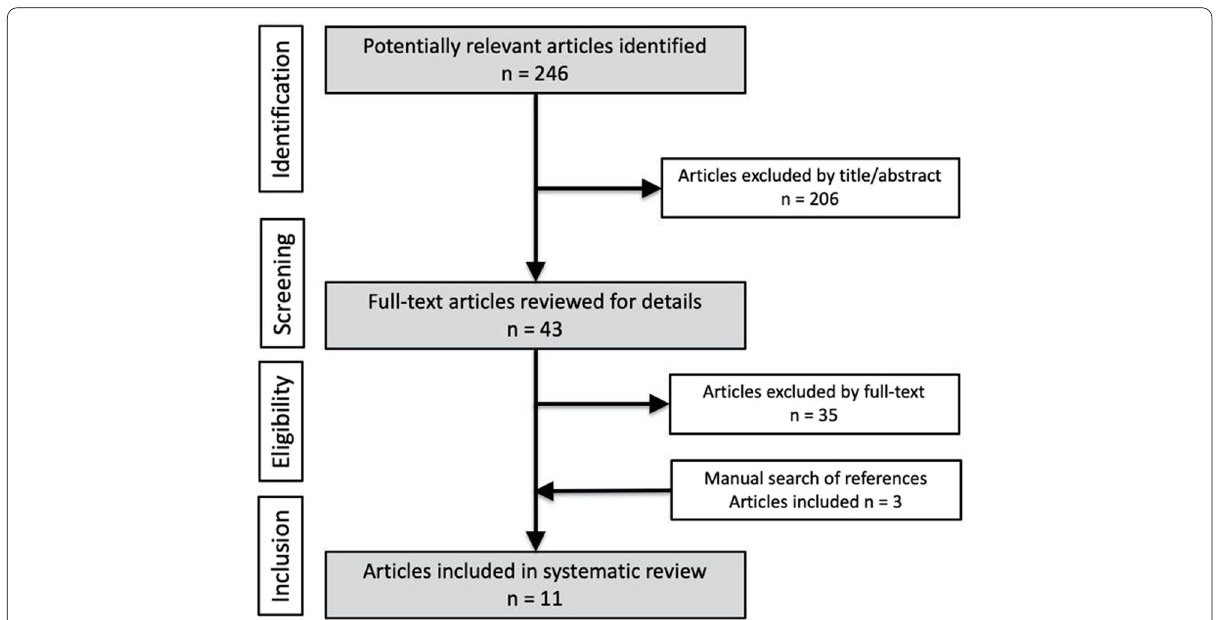
Fig. 2 PRISMA flow